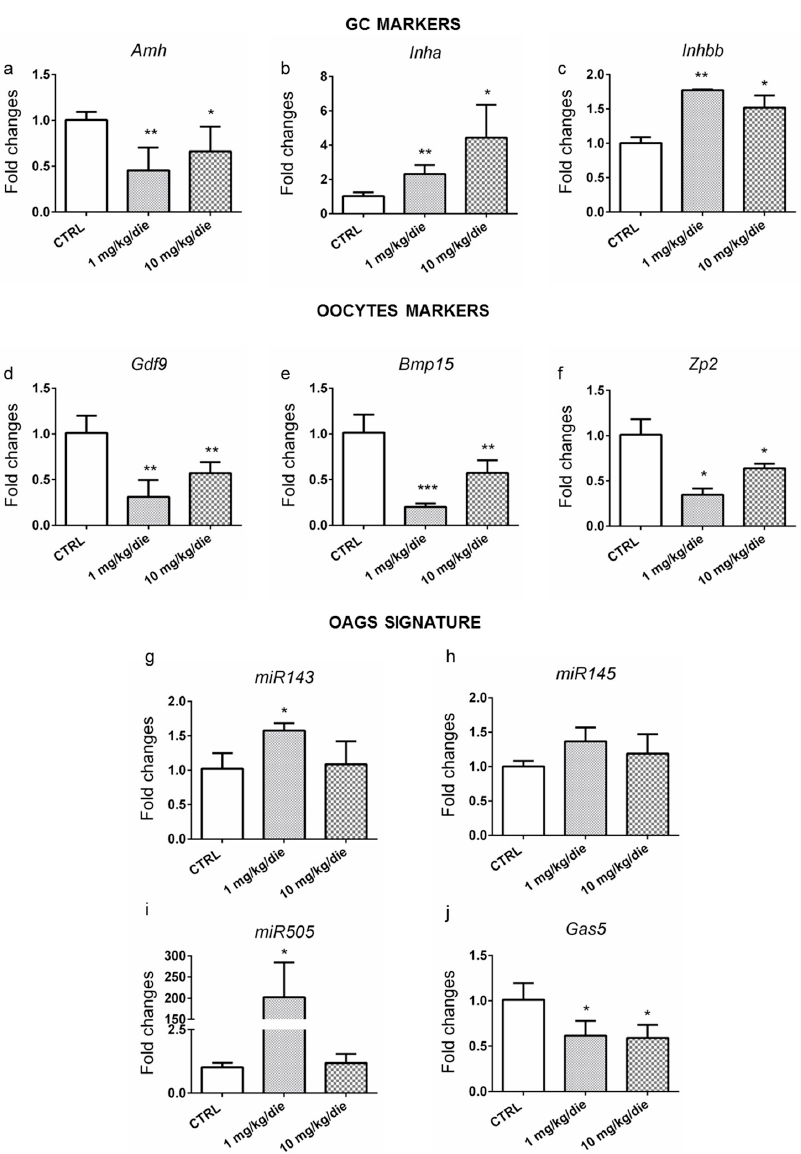
Figure 4. Developmental and life-long exposure to CPF affects OAGS in mice. ( a – f ) RT-qPCR analyses of the levels of markers of granulosa cells ( Amh, Inha, and Inhbb ) and markers of oocytes ( Gdf9, Bmp15, and Zp2 ). ( g – j ) OAGS genes ( miR143 , miR145, miR505, and Gas5 ) were verified by RT-qPCR. RT-qPCR tests were performed on five biological samples ( n = 5 ovaries/group). Data are reported as fold change values calculated as a ratio between average relative gene expression in exposed and control ovaries after normalization on β -actin mRNA ( U6 for miRNA). Significant differences are indicated with * p < 0.05, ** p < 0.01 and *** p < 0.001 using Student’s t -test. Then, we evaluated CPF exposure effects on ovarian customization of T3 signaling.